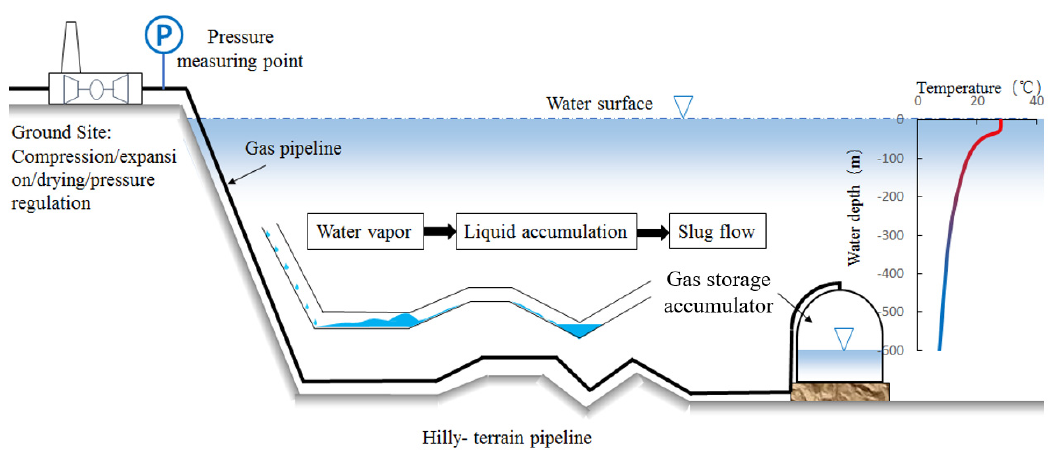
Figure 1. Formation of slug flow in transmission pipeline.